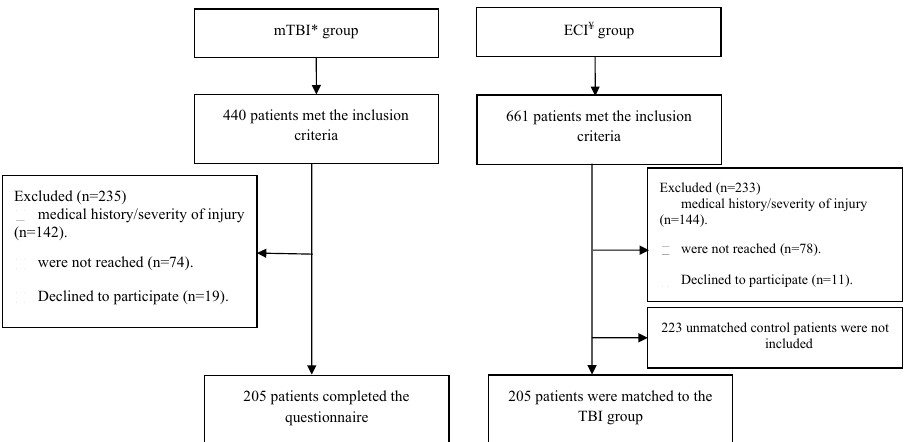
Figure 1. Flowchart of the patients in the study. *mTBI-mild traumatic brain injury. ¥ ECI- extracranial injury.